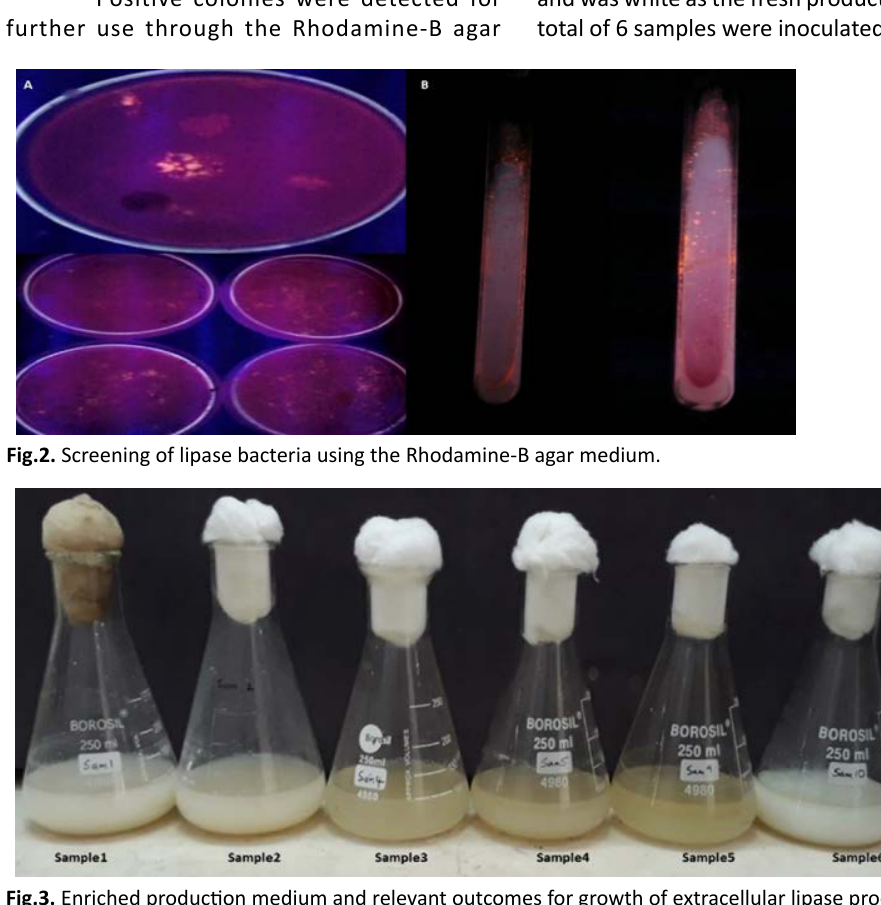
Fig.3. Enriched production medium and relevant outcomes for growth of extracellular lipase producing